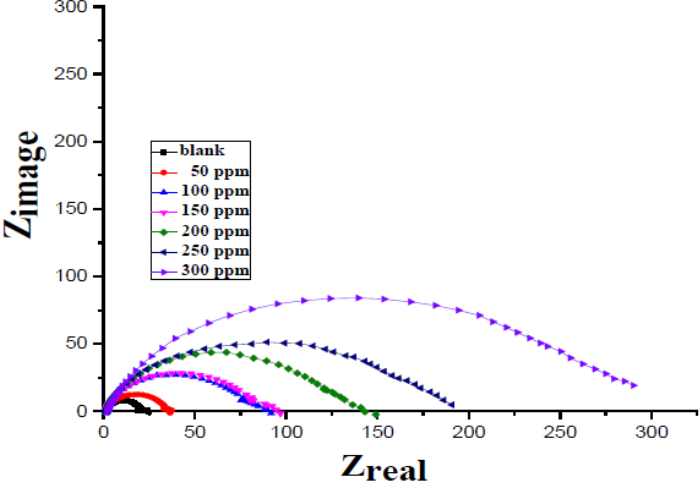
Figure 17. Nyquist plot for various concentrations of Clinopodium acinos extract. Reprinted from [51].